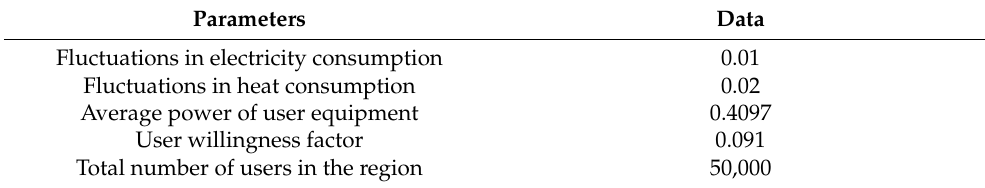
Table 7. Parameters related to load